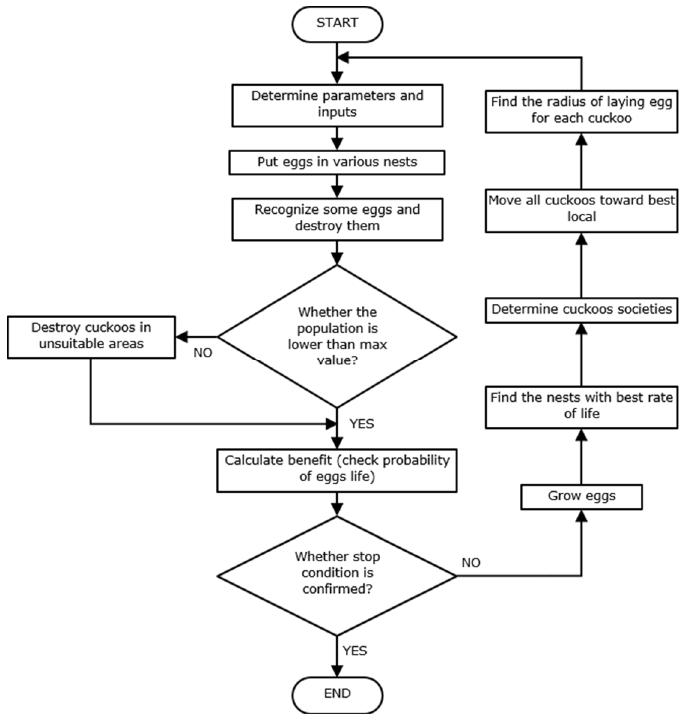
Figure 3. Cuckoo Search Algorithm Flowchart.